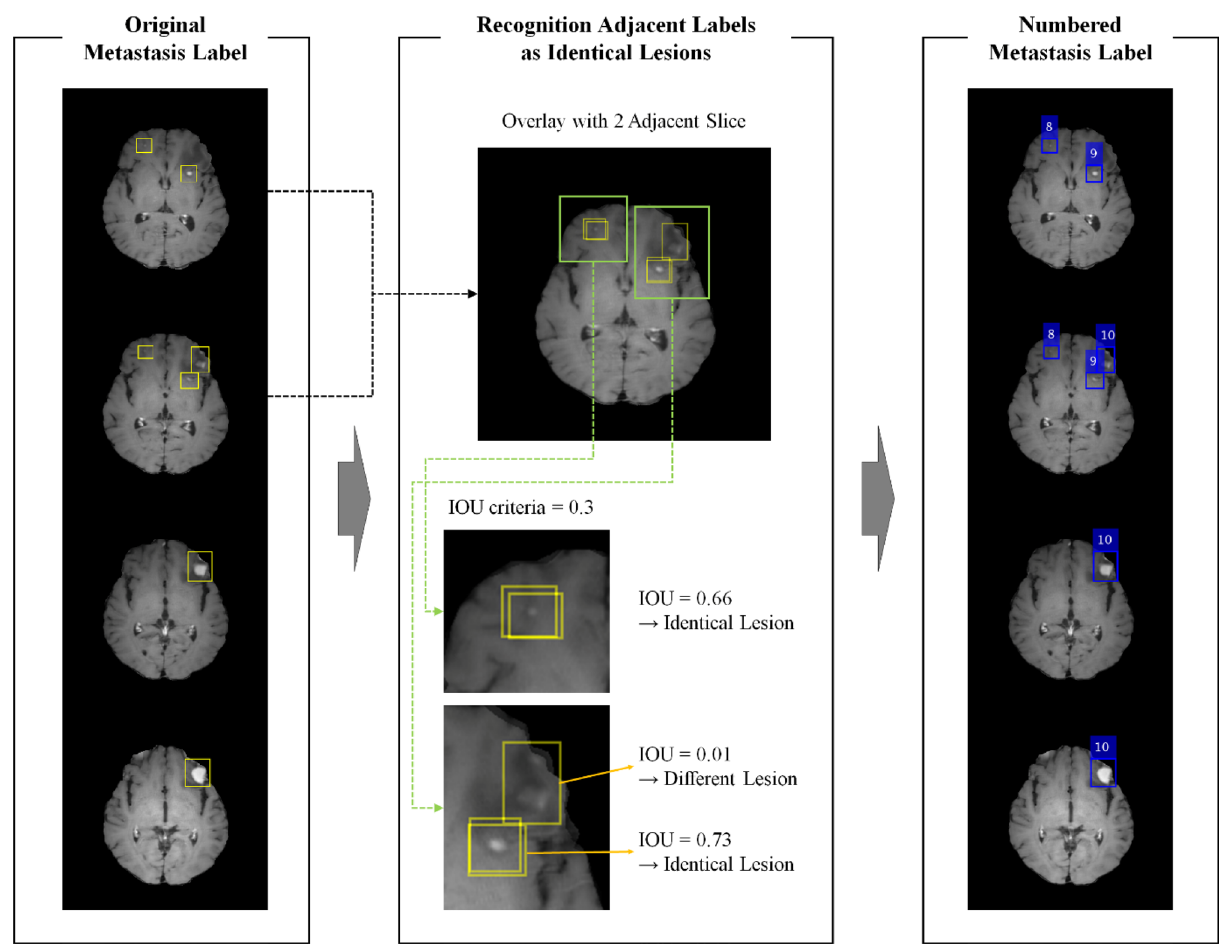
Figure 5. The flowchart for recognition of adjacent labels as identical lesions. Each label was identified per lesion and granted the lesion number for each lesion. Yellow boxes show the original labels and blue boxes show the label that the lesion placed more than two adjacent slices. This figure was generated by MATLAB (MathWorks, R2020b, Natick, MA, USA) and PowerPoint 2016 (www. micro soft.